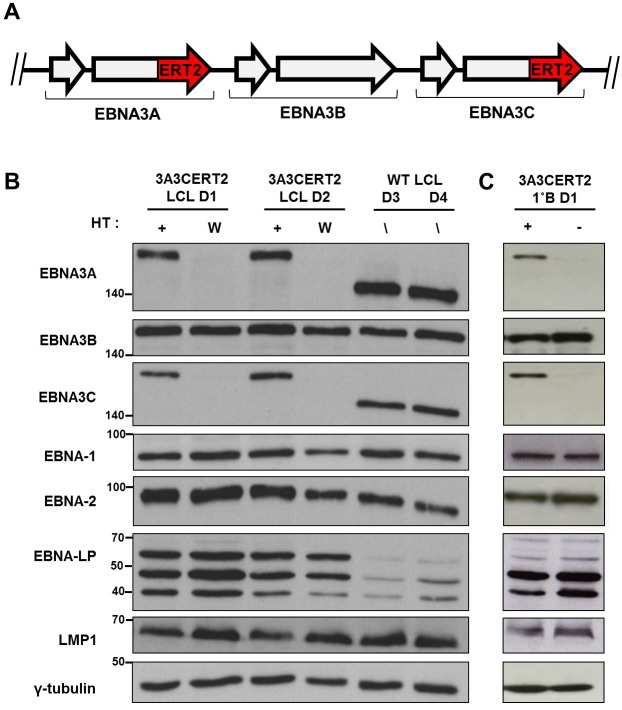
Validation of double-conditional 3A3CERT2-infected cells.(A) Schematic showing ERT2 fusion to the C-terminus of EBNA3A and EBNA3C open reading frames (3A3CERT2). (B) Expression of Epstein-Barr virus latency-associated proteins EBNA1, EBNA2, EBNA3A, EBNA3B, EBNA3C, EBNA-LP, and LMP1 was demonstrated by western blotting extracts from 3A3CERT2 lymphoblastoid cell lines (LCLs) derived from 2 donors (3A3CERT2 LCL D1, 3A3CERT2 LCL D2) cultured with 4-hydroxytamoxifen (HT) (+) or washed and grown without HT for 30 days (W), ‘WT’ (B95.8-BAC) LCLs derived from 2 donors (WT D3, WT D4) and (C) Primary CD19+ve B cells 20 days post-infection with 3A3CERT2 recombinant (1°B D1) cultured with (+) or without (-) HT. In each blot γ-tubulin was used as a loading control; molecular weight markers are shown in kDa.